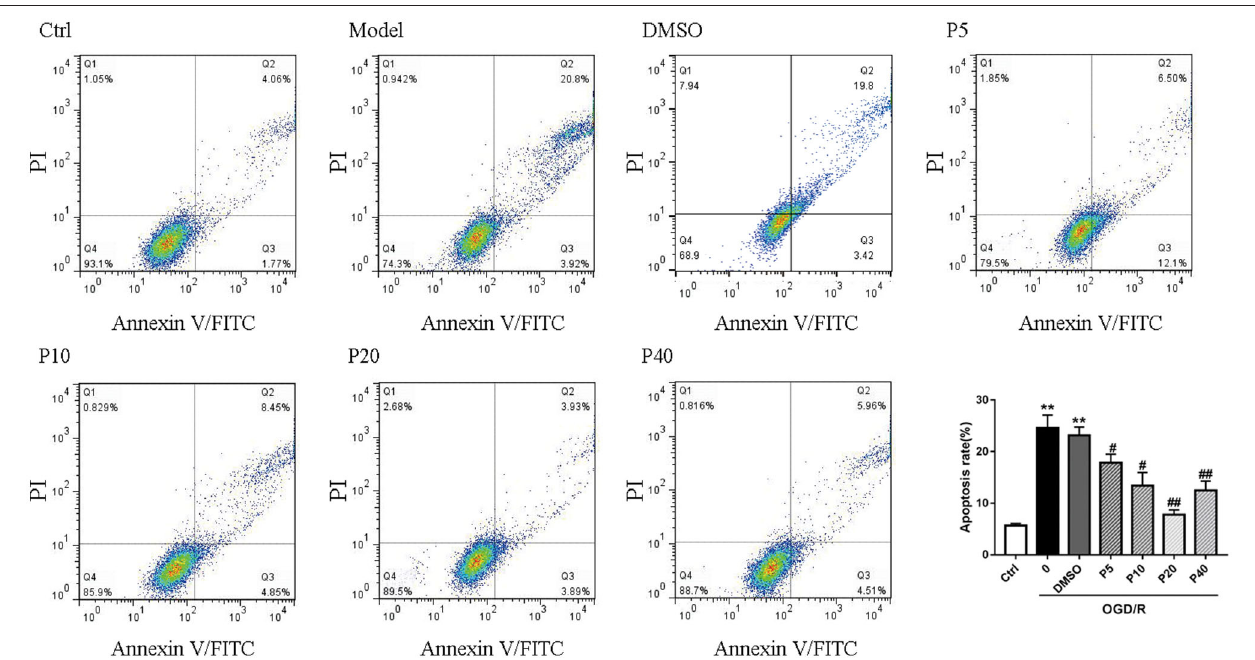
FIGURE 2 | Propofol inhibited cell apoptosis induced by OGD/R in H9c2 cells. Quantification of the apoptotic cell population by flow cytometry. Propofol decreased the percentage of apoptotic cells compared with the model. The data are presented as the mean ± SD of three independent experiments. * p < 0.05, ** p < 0.01, *** p < 0.001 versus control, # p < 0.05, ## p < 0.01, ### p < 0.001 versus OGD/R treated group without